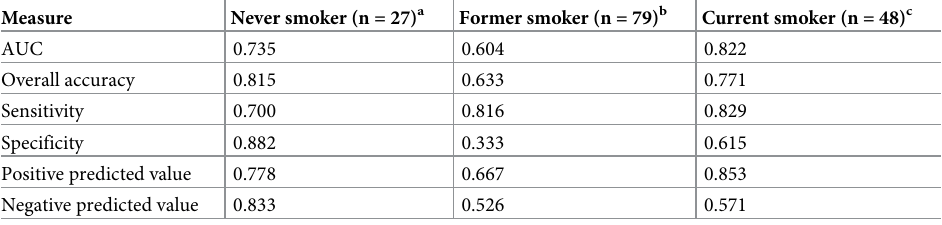
Of the 73 predictors included in the SGB models, 17 (23.3%) had a non-zero influence for never smokers, 36 (49.3%) for former smokers, and 26 (35.6%) for current smokers. The ten predictors with the highest NRI for the SGB models, according to smoking status, are given in Table 4. Age was the dominant predictor regardless of smoking status, accounting for 51.0% of the influence on the probability of being diagnosed with lung cancer among never smokers, 35.3% of the influence among current smokers, and 28.6% of the influence among former smokers, while education level and sex came in as the second and third most important predic- tor, respectively, with NRI values between 6 and 10 percent. Of the other variables, “Breathing worse upon exertion” was among the five most important predictors for all smoking groups, with NRI values > 5.0% for both never smokers and current smokers, while “Antibiotics within the past 2 years”, “Cough varied over the day”, “Voice got hoarser”, and “A cold, flu or pneumonia within the past 2 years” were all among the top ten predictors for all smoking groups, with NRI values between 1.9 and 5.7 percent. Notably, the predictor “Haemoptysis/ hematemesis” (blood-mixed/brown sputum) had a non-zero influence for never smokers and smokers. For former smokers, “Haemoptysis/hematemesis”was ranked 26 th among the 36 pre- dictors with non-zero influence, with an NRI of only 0.56%. Table 3. Performance measures for predictions of lung cancer status for patients in the test data sets using sto- chastic gradient boosting models from the training data sets, according to smoking